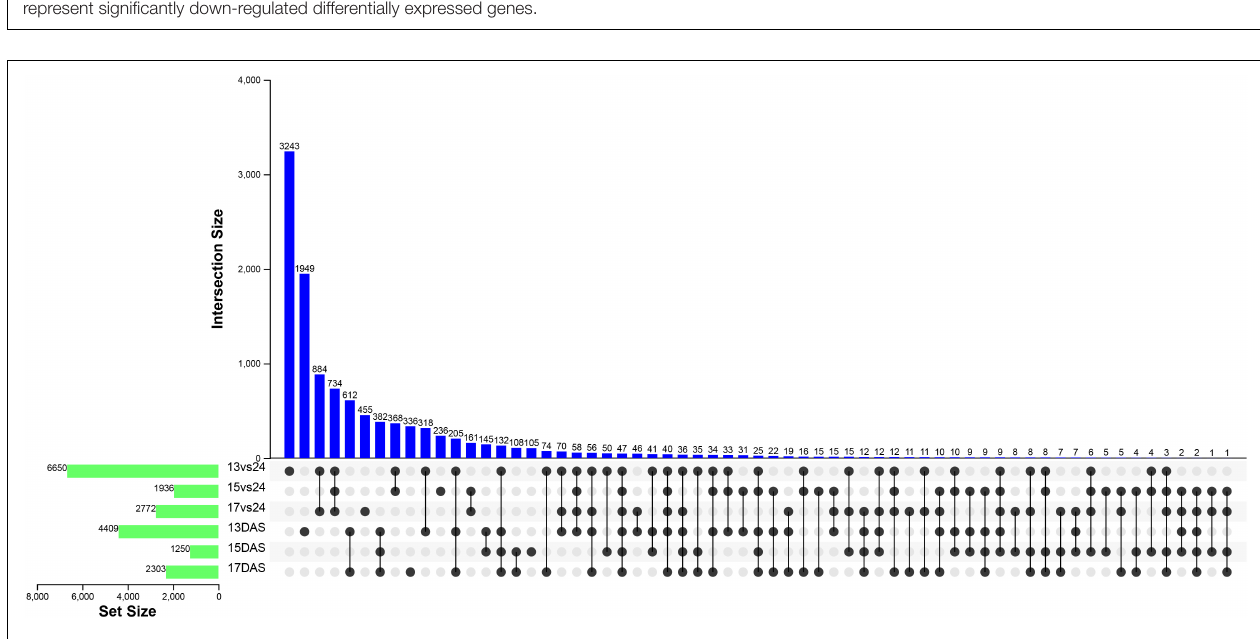
FIGURE 1 | Volcano scatter plots of differentially expressed genes. Red points represent significantly up-regulated differentially expressed genes. Blue points represent significantly down-regulated differentially expressed genes.